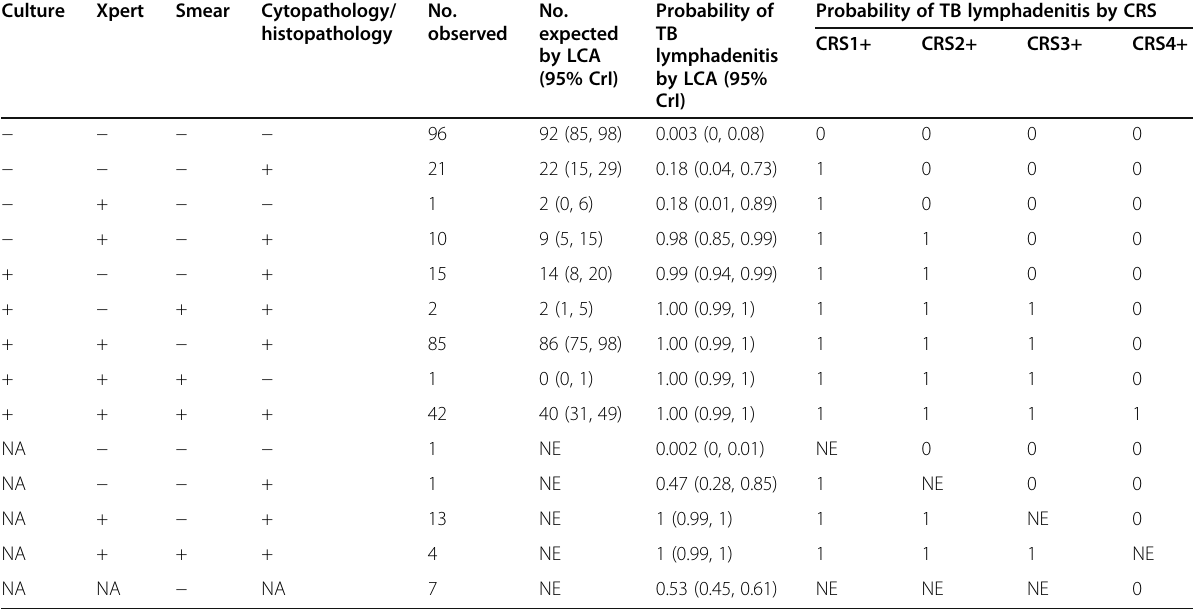
Table 4 Observed counts, expected counts, and TB lymphadenitis probability by test result pattern Culture Xpert Smear Cytopathology/